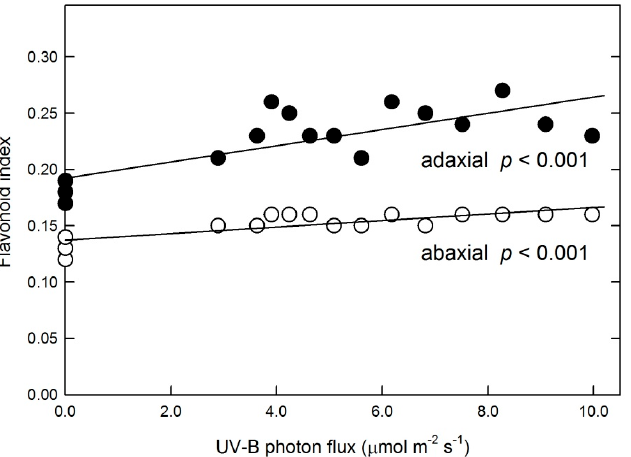
Figure 6. Changes in adaxial (filled symbols) and abaxial (empty symbols) flavonoid index values in response to various UV-B photon fluxes. Symbols represent data of individual leaves and lines show results of linear fits characterized by corresponding p -values.